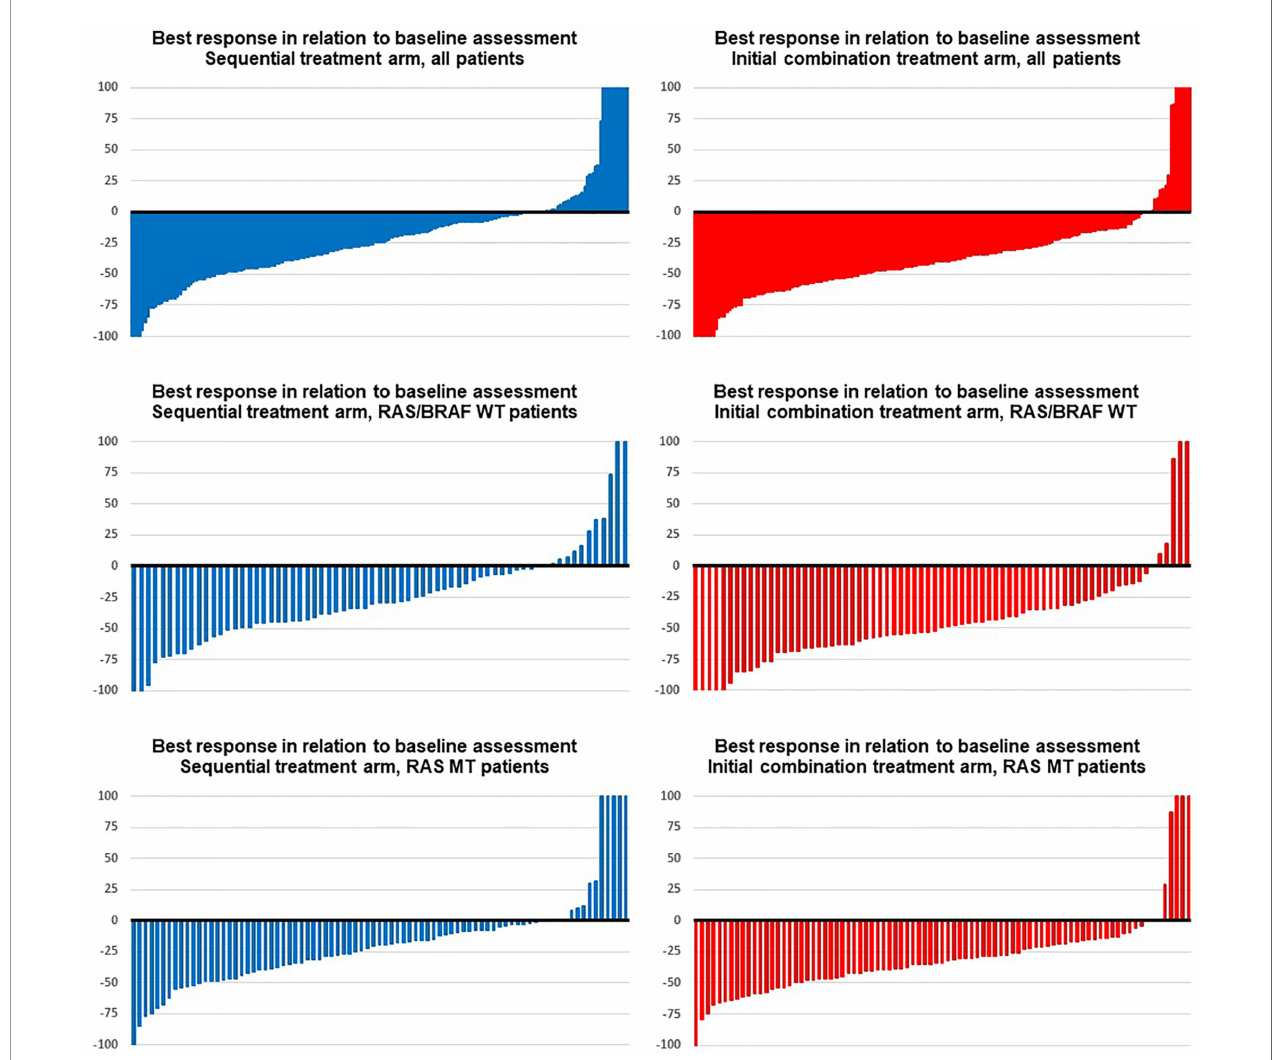
FIGURE 1 | Best response in the trial. Blue images display response assessments of the sequential treatment arm ( fl uoropyrimidine plus bevacizumab), and red images show response assessments of the initial combination treatment arm ( fl uoropyrimidine, bevacizumab, and irinotecan) in (from top to bottom) groups: all patients, RAS/BRAF wild type, RAS